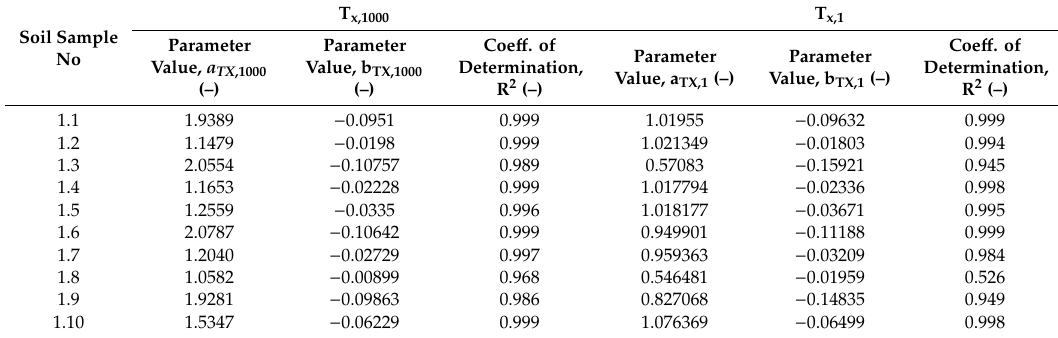
Table A3. The value of the a TX,1 and b TX,1 and b TX,1000 parameters based on nonlinear regression